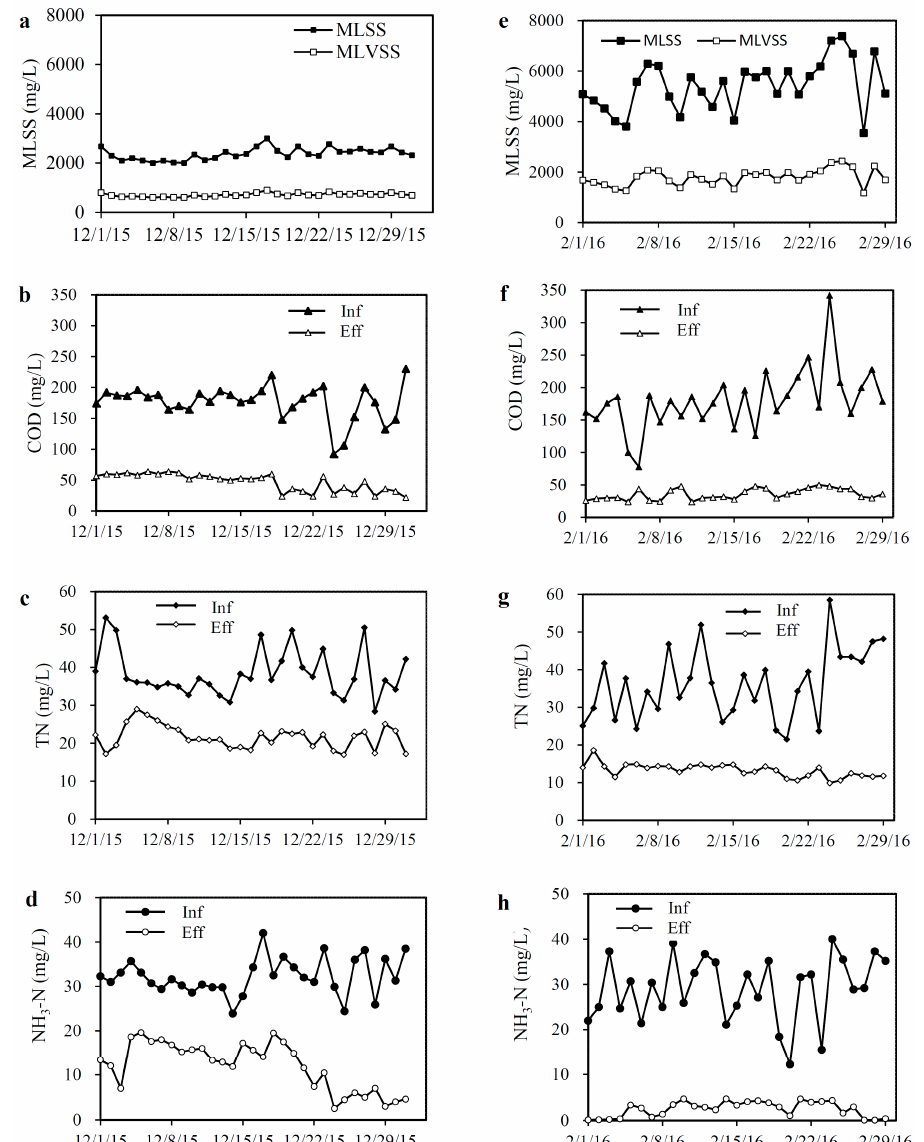
Figure 4. The water quality in Case-1 WWTP before and after the optimization through data mining. ( a – d ) MLSS, MLVSS, COD, TN, and NH 3 -N in December 2015 before the optimization; ( e – h ) MLSS, MLVSS, COD, TN, and NH 3 -N in February 2016 after the optimization. MLVSS—suspended solids in mixed liquor; MLVSS—volatile suspended solids in mixed liquor; Inf—influent; Eff—effluent.